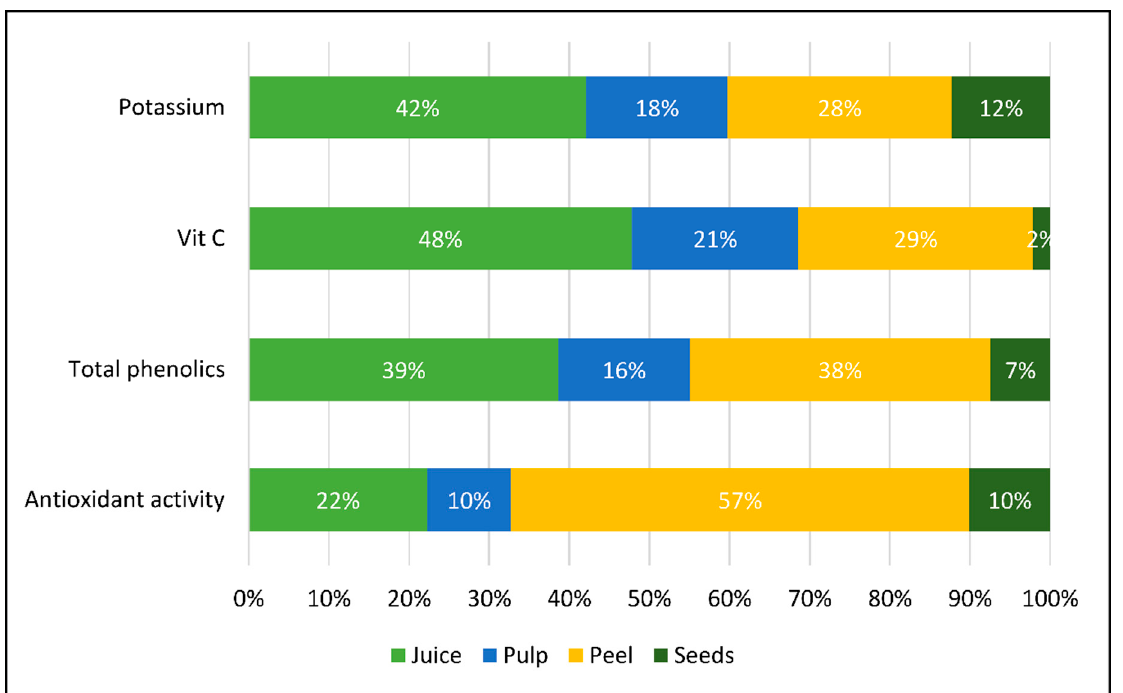
Figure 3. Weight distribution of antioxidant activity, total phenolics, vitamin C and potassium by melon parts.